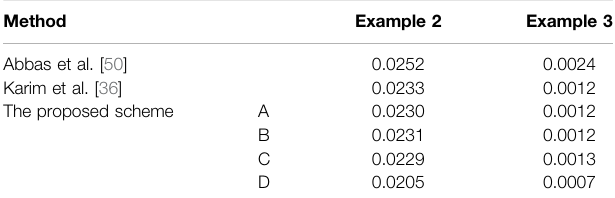
TABLE 6 | Root mean square error (RMSE) values. TABLE 7 | Coef fi cient of determination ( R 2 ) values.